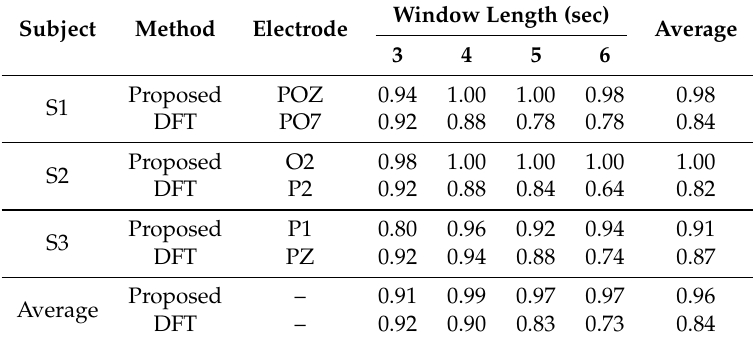
Table 2. The classification rate of each subject under different window